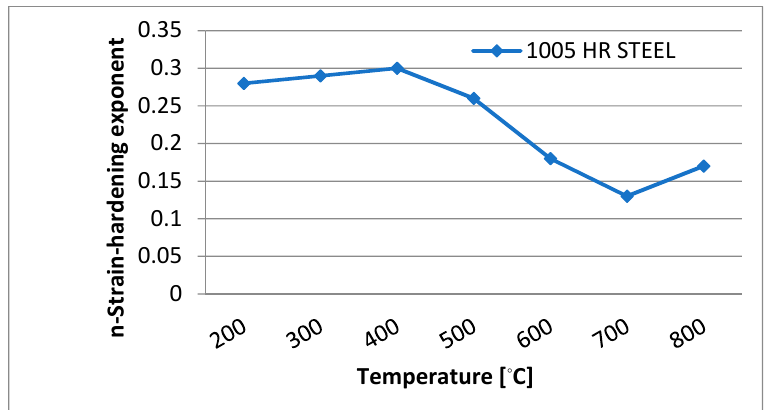
Figure 2. Coefficient versus temperature for a 1005 hot rolled steel specimen.